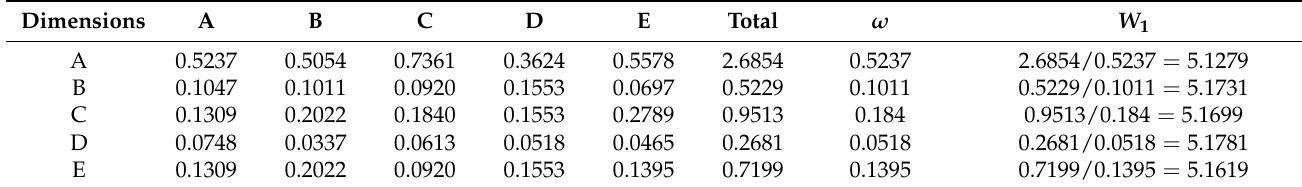
Table 8. The calculation of maximum eigenvector for five main